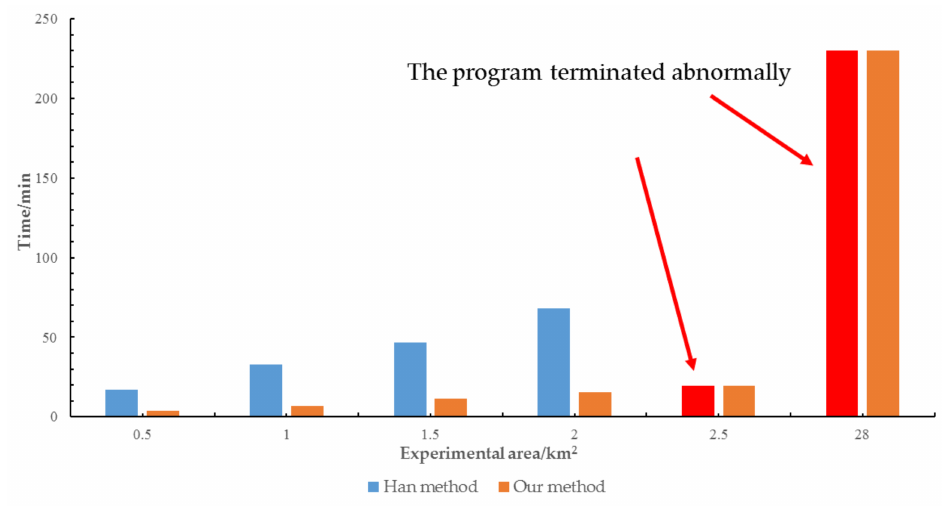
Figure 12. Bar graph for the time consumption comparison.